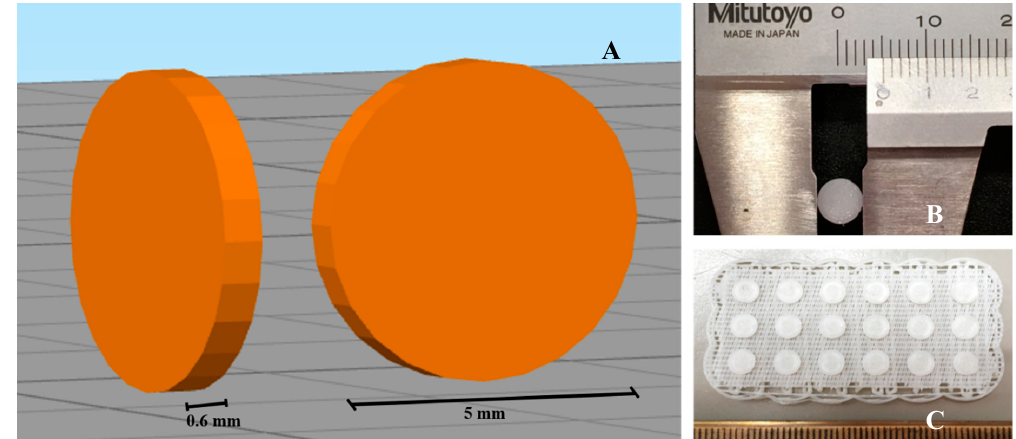
Figure 1. 3D printed polymer disc. ( A ) 3D rendering of a polymer disk. ( B ) Close-up of a printed